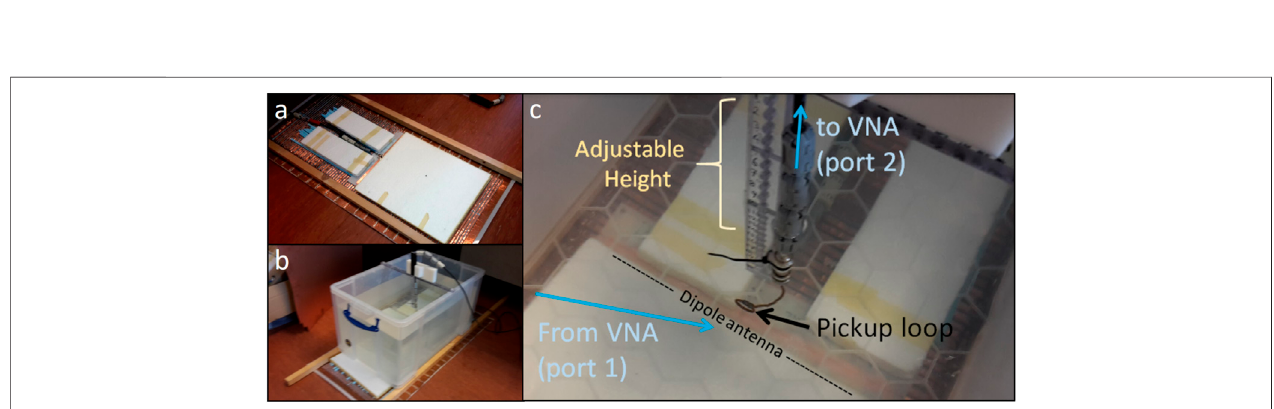
FIGURE 4 | (A) Photograph of split ring shield with foam spacers and dipole antenna (length (cid:1) 300 mm). (B) Measurement setup with SRS, dipole antenna, foam spacers, salt water tank ( σ (cid:1) 0.5 S/m), and pickup loop inside the water. (C) Close-up of the pickup loop positioned inside the water. The dipole is oriented in the z -direction, the loop position varies in the x -direction, and the loop is oriented in the xz-plane.